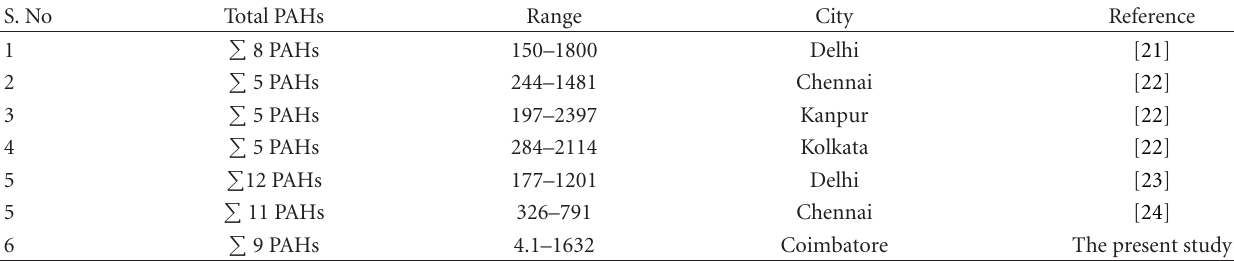
Table 3: Comparison of total PAHs (ng/m 3 ) in various cities of the